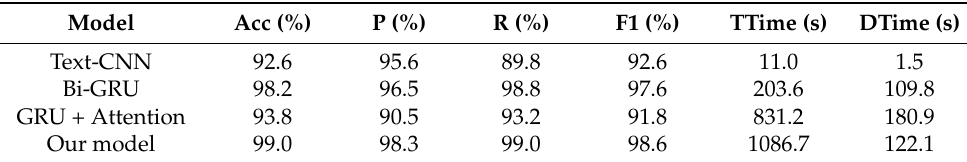
Table 4. Results for RQ2. Comparison of 4 different neural networks.